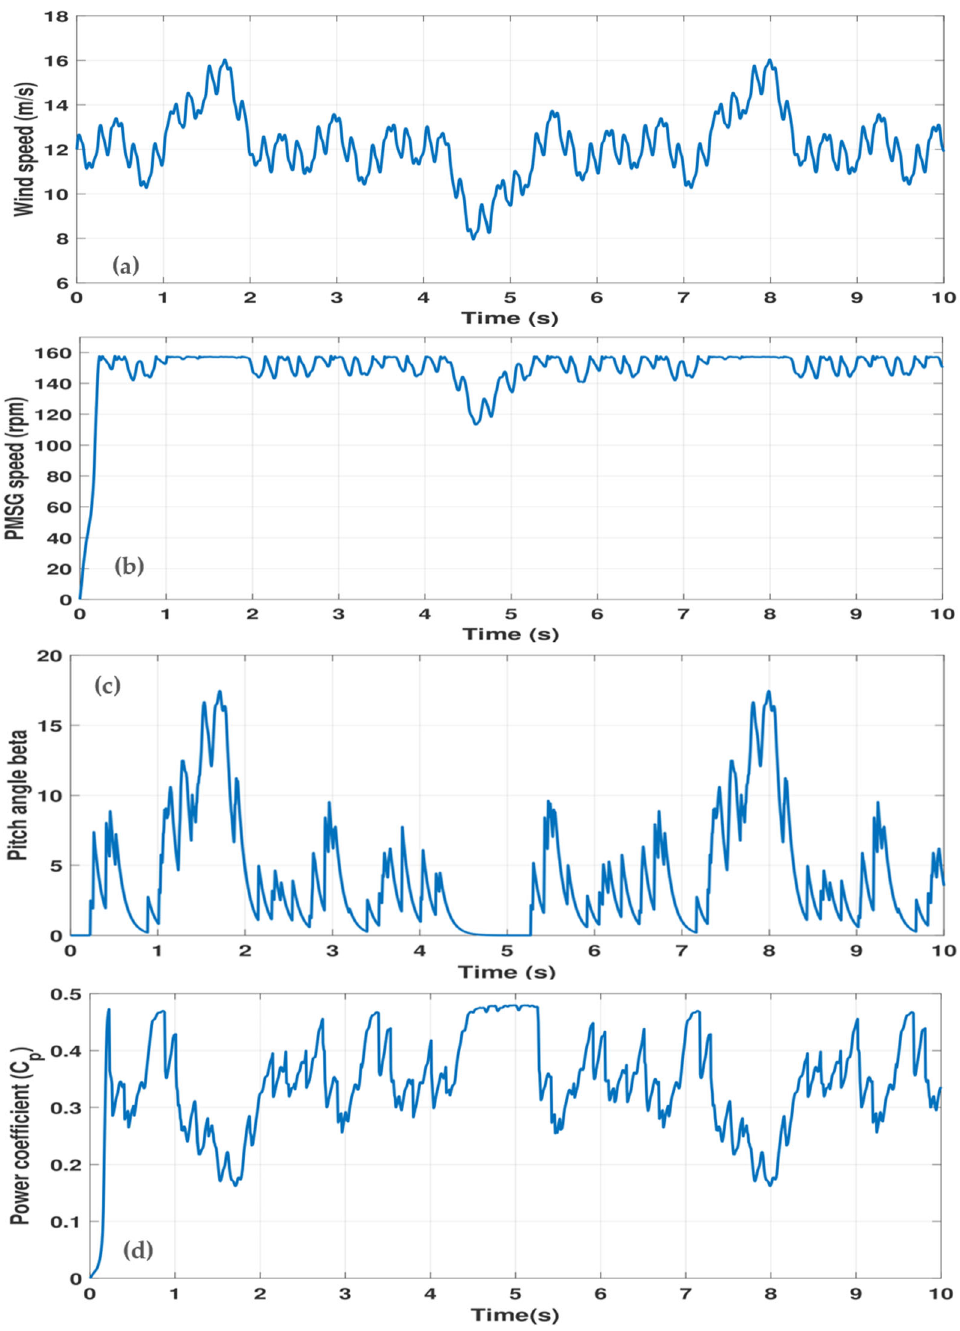
Figure 22. ( a ) Wind speed, ( b ) mechanical speed, ( c ) pitch angle β and ( d ) power coe ffi cient.